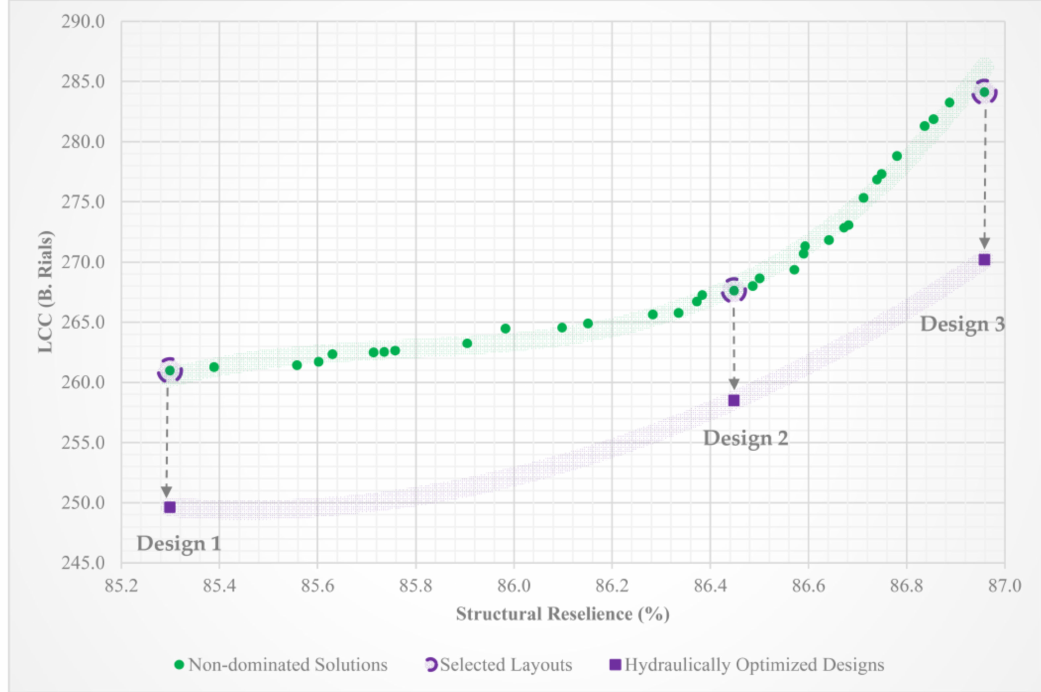
Figure 6. Pareto front of non-dominated solutions, selected layouts, and their respective hydraulically optimized costs.